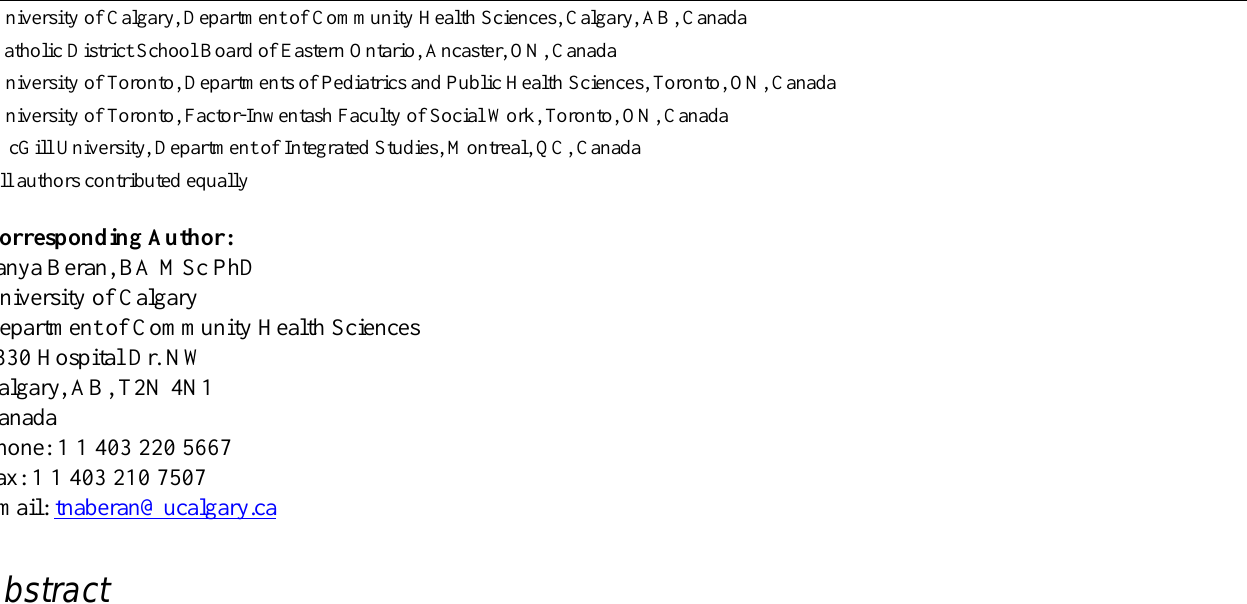
mental health; school bullying; cyberbullying; peer victimization; psychosocial impact;